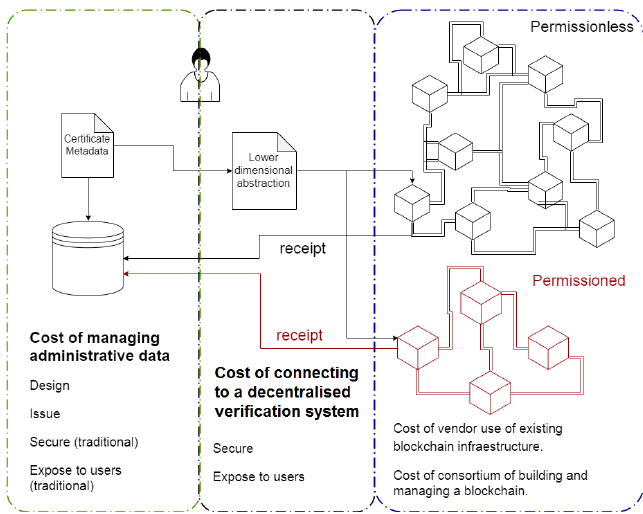
Figure 1: Management of academic certificates using Blockchain